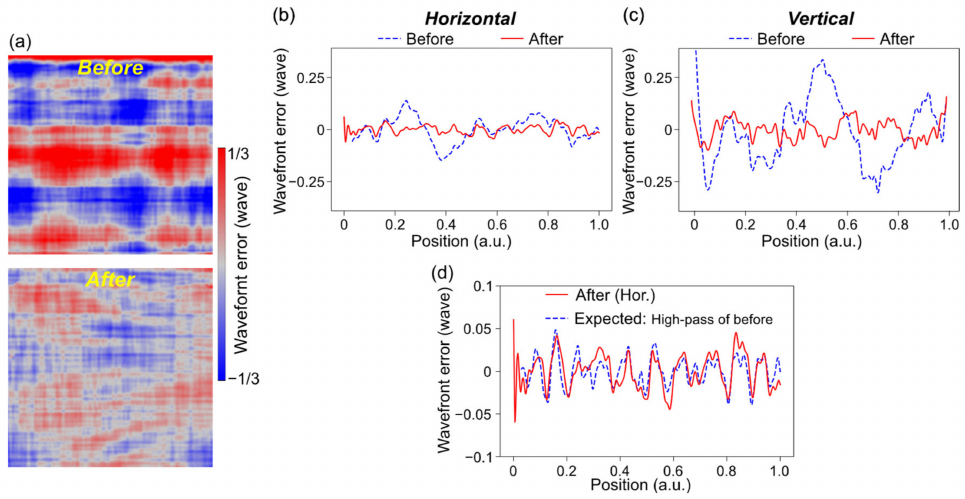
Figure 6. Results of the X-ray wavefront correction (XWC). ( a ) 2D wavefront errors originating from shape errors on the focusing mirrors before (top) and after (bottom) the correction. ( b , c ) 1D wavefront error profiles in the horizontal ( b ) and vertical ( c ) directions. ( d ) Comparison between the horizontal profiles of the corrected wavefront and of the expected wavefront, which is the high-pass filtered profiles before the